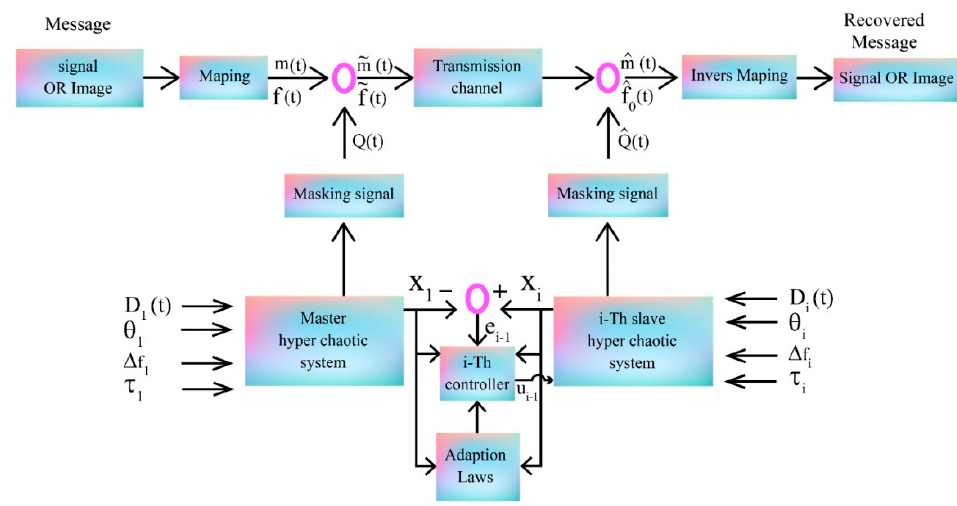
Figure 3. Block diagram of chaotic masking with multi-state Figure-3. Block diagram of chaotic masking with multi-state synchronization.